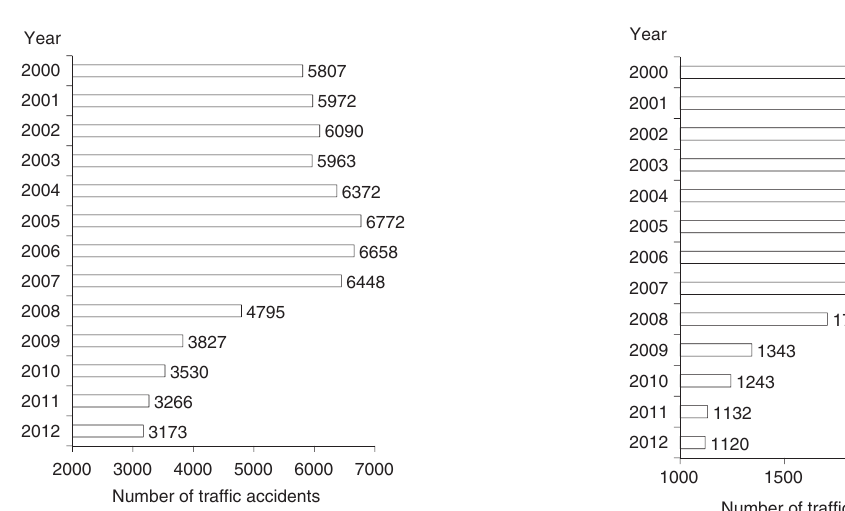
Fig. 6. The dynamics of traffic accidents, involving Running over pedestrians , registered by the Traffic Police of Lithuania in 2000 (cid:2)